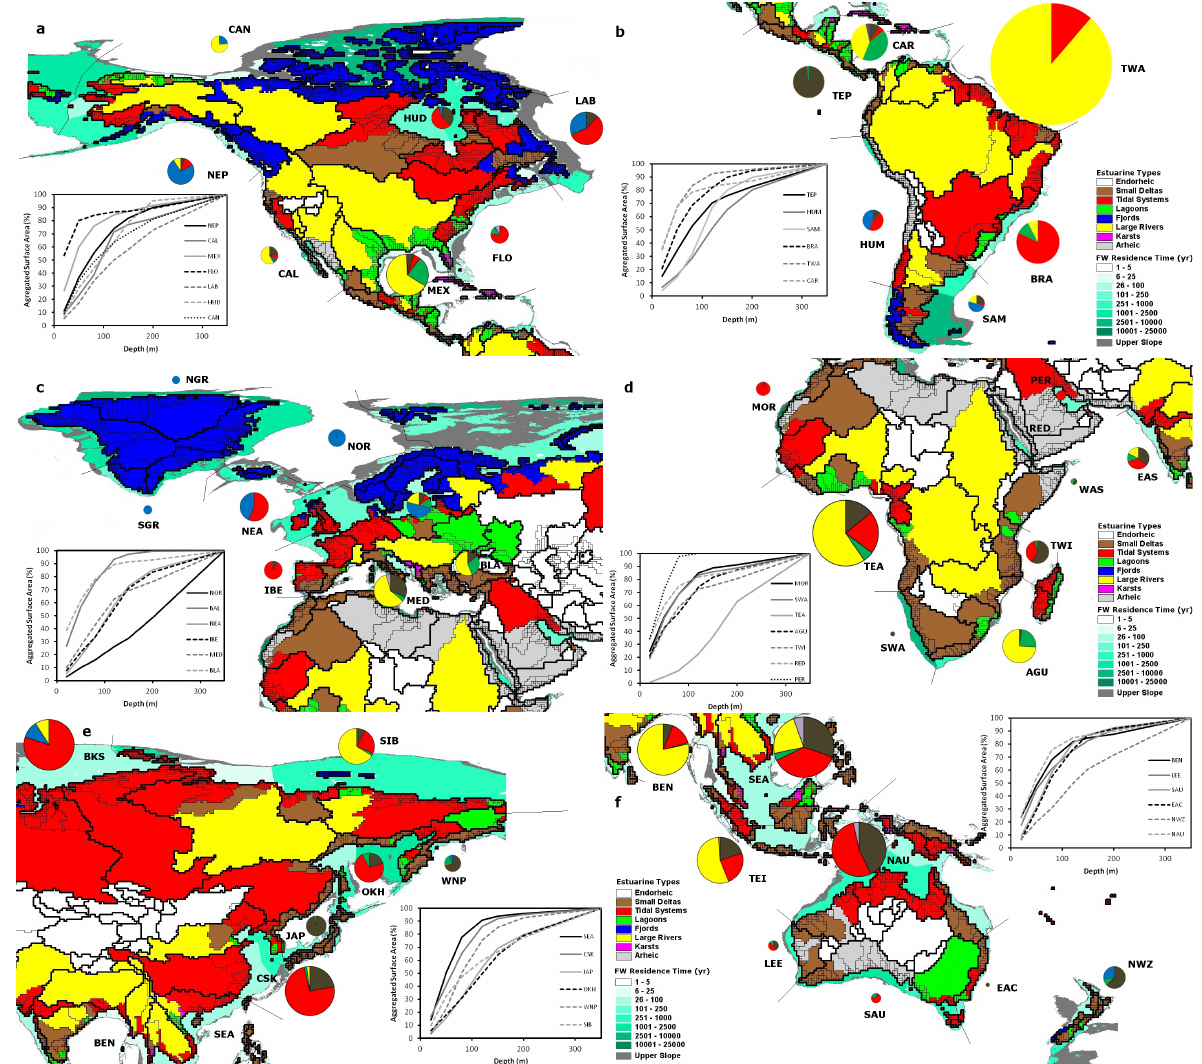
Fig. 5. Map representing the COSCAT segments (bold lines) and their corresponding continental shelf. The colour of the shelf indicates the freshwater residence time, and the grey area represents the geographic extent of the upper slope (from the shelf break until the − 1000m isobaths). Within each COSCAT the limits of all watersheds are indicated at a 0.5 degree resolution, and the colour code indicates the type of estuarine filter at the interface between the river and the shelf. The limits of the MARCATS segments are indicated by the grey lines and, for each one, a pie chart represents the total freshwater discharge from rivers and its distribution amongst the different estuarine types. The size of the pie is proportional to the total water discharge for a given MARCATS. The panel provides the integrated surface area of the shelf with respect to the depth of its outer limit for each MARCATS